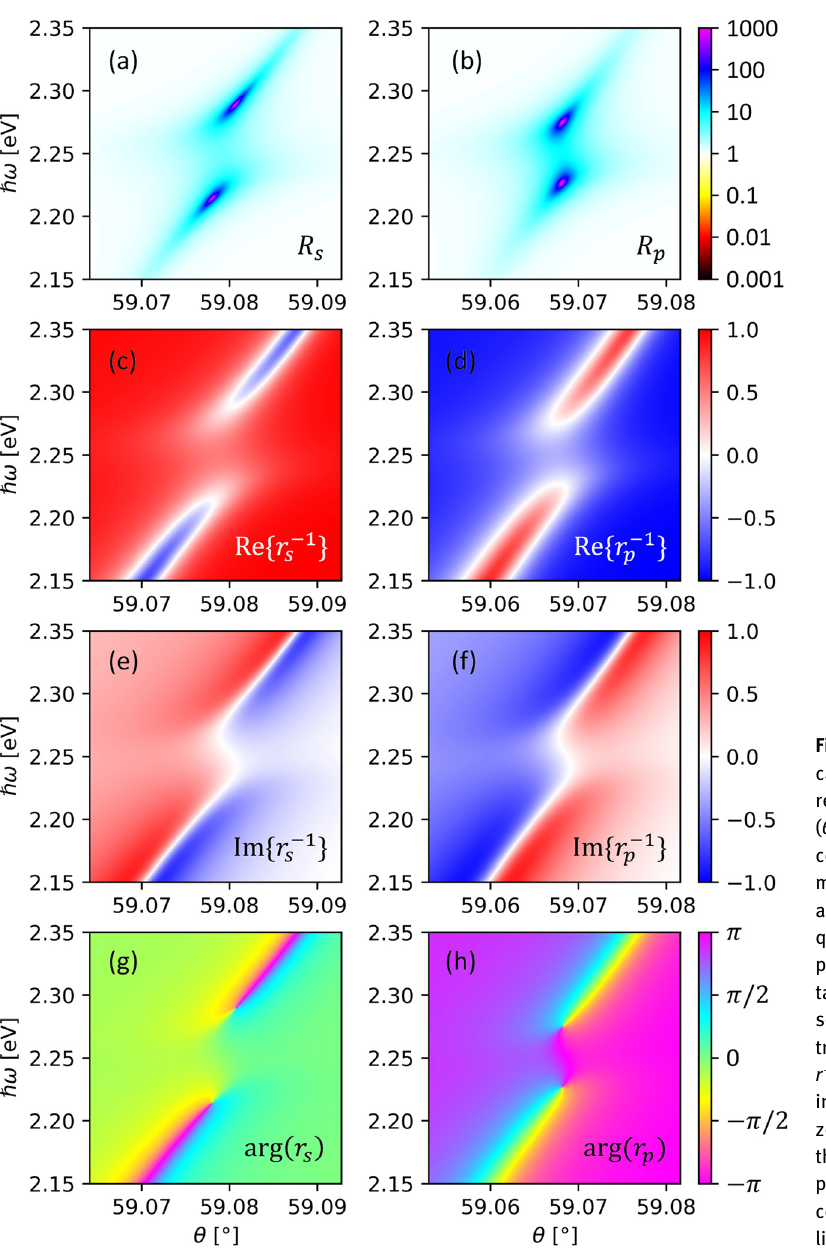
Figure 7a and b for both s and p incident polarization, resulting fromtheintersectionsoftherealandtheimaginary sign-change contours in r − 1 shown in Figure 7c – f. The dis- tribution of the complex-valued re fl ection coef fi cient r around these points features pairs of phase vortices, shown in Figure 7g and h, similar to the vortices observed in Figure 4e – h. In the full frequency – momentum space ( k x – k y – ω ), each of these singularies would appear as a ring due to full rotational invariance of the slab, as opposed to periodic metasurfaces, where the singularities are aligned with the edges of Rayleigh anomalies. Furthermore, as